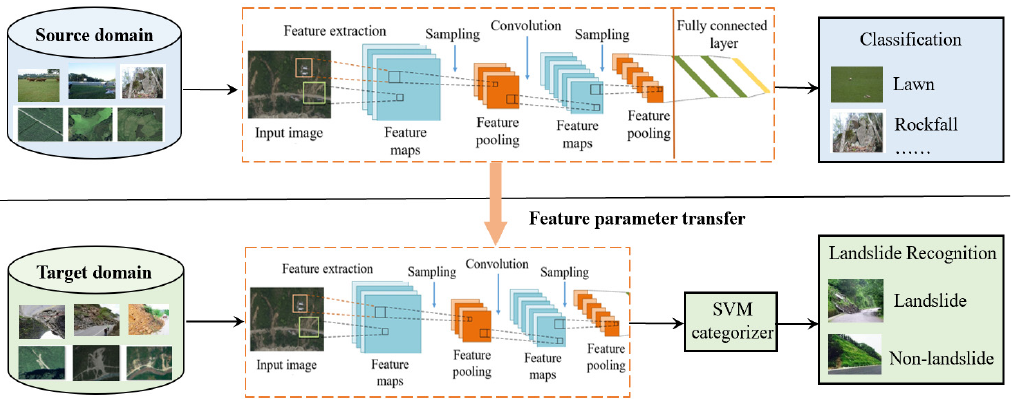
Figure 7. Transfer learning flow chart.